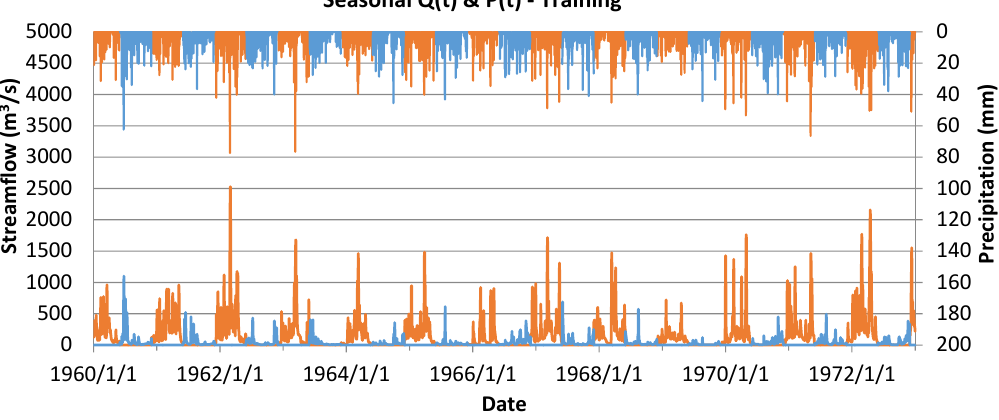
Figure 2. Streamflow and precipitation record for the training dataset. Red represents the high flow seasons while blue represents the low flow seasons.